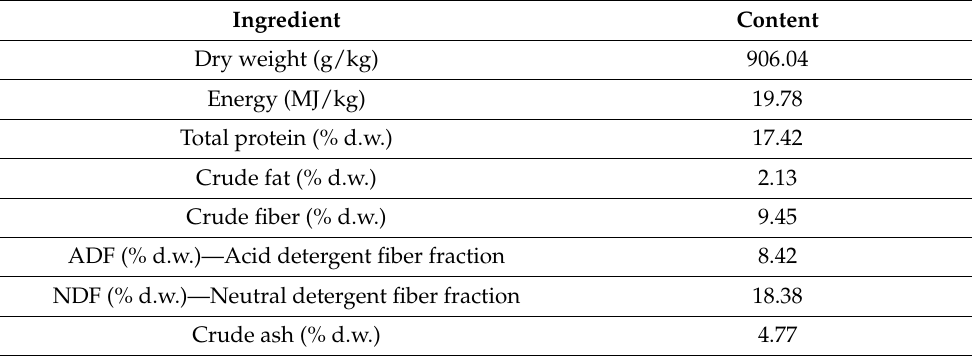
Table 2. Nutritional value of pelleted feed fed to Wistar